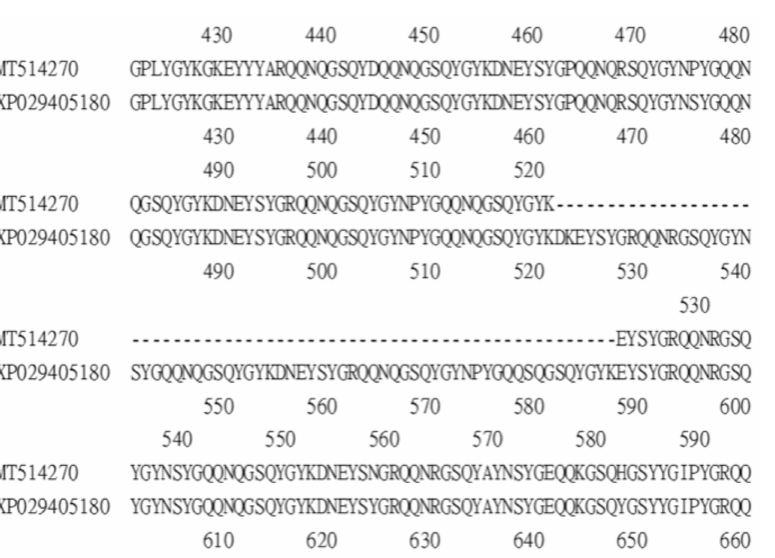
Figure 3. Alignment between Bdfbp1 MT514207 (amino acid sequence 421–594) and Bdfpb1 XP029405180 (amino acid sequence 421–660) shows that MT514207 is 66 amino acids shorter than XP029405180.